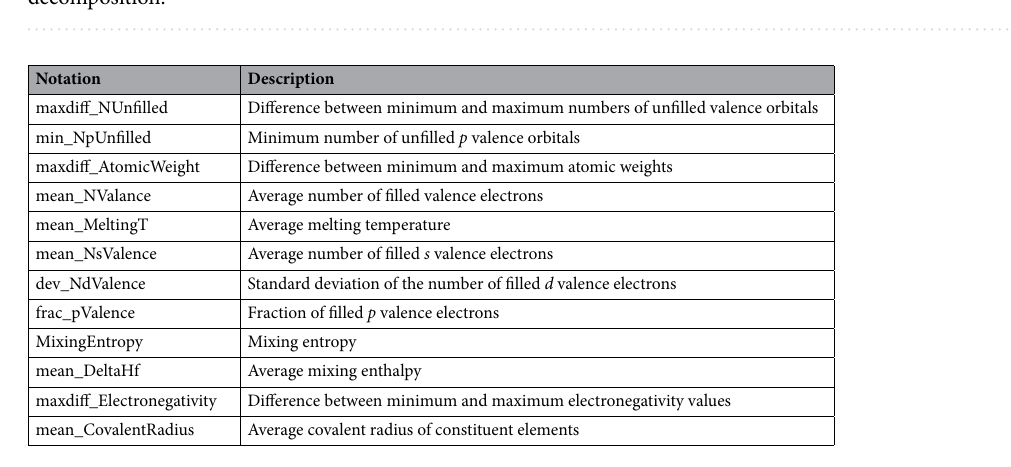
Table 1. List of the 12 descriptors selected from 125 descriptors by